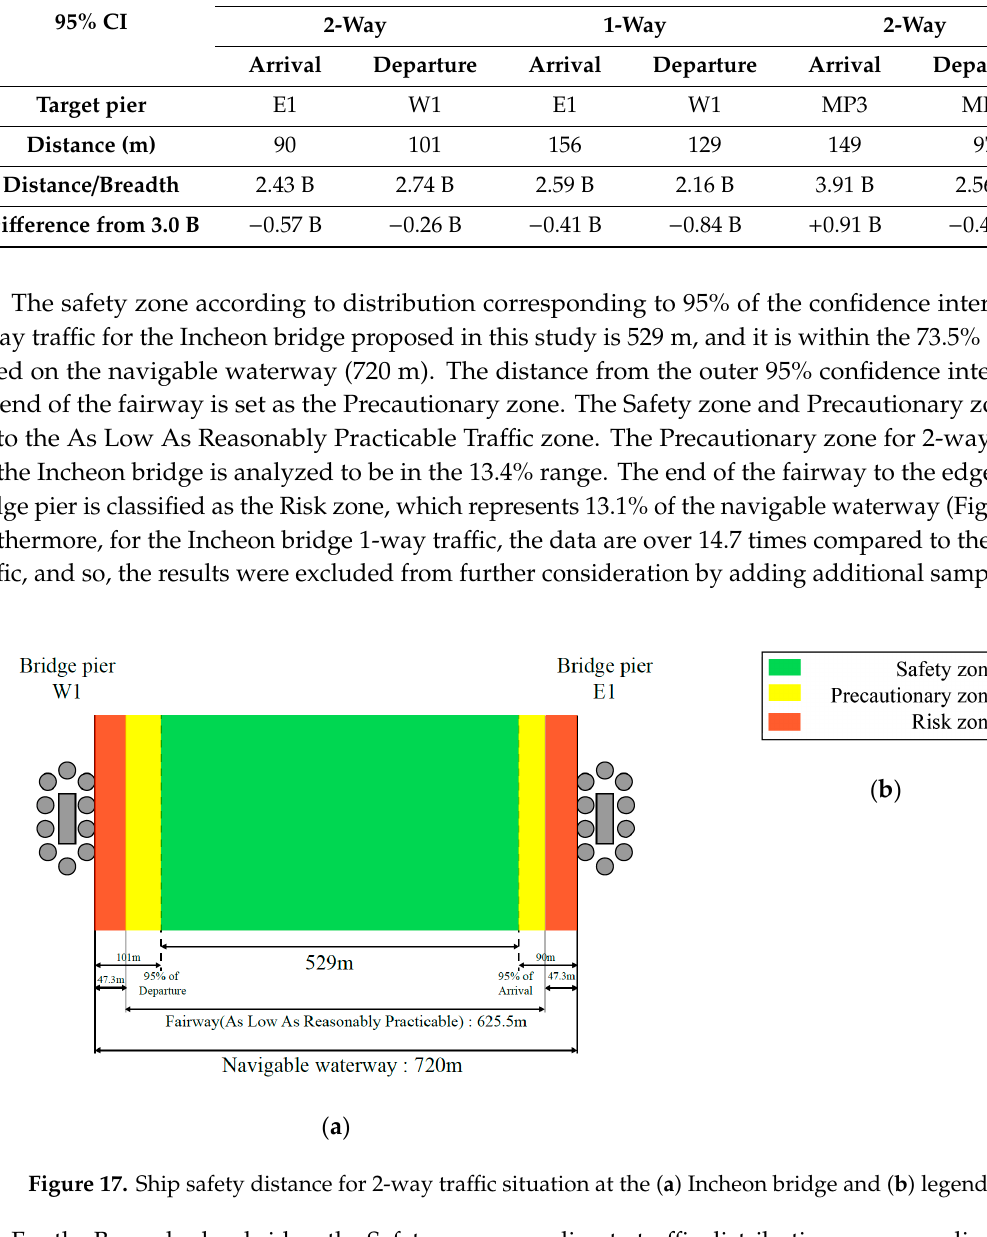
Figure 18. Ship safety distance for 2-way traffic at the ( a ) Busan harbor bridge and ( b ) legend. 6. Conclusions For ship passage safety, a bridge across a waterway constitutes an accident risk factor. However, no safe distance standard between a bridge across a waterway and ships currently exists under the laws and regulations of Korea. In this study, according to traffic distribution, the Incheon and Busan